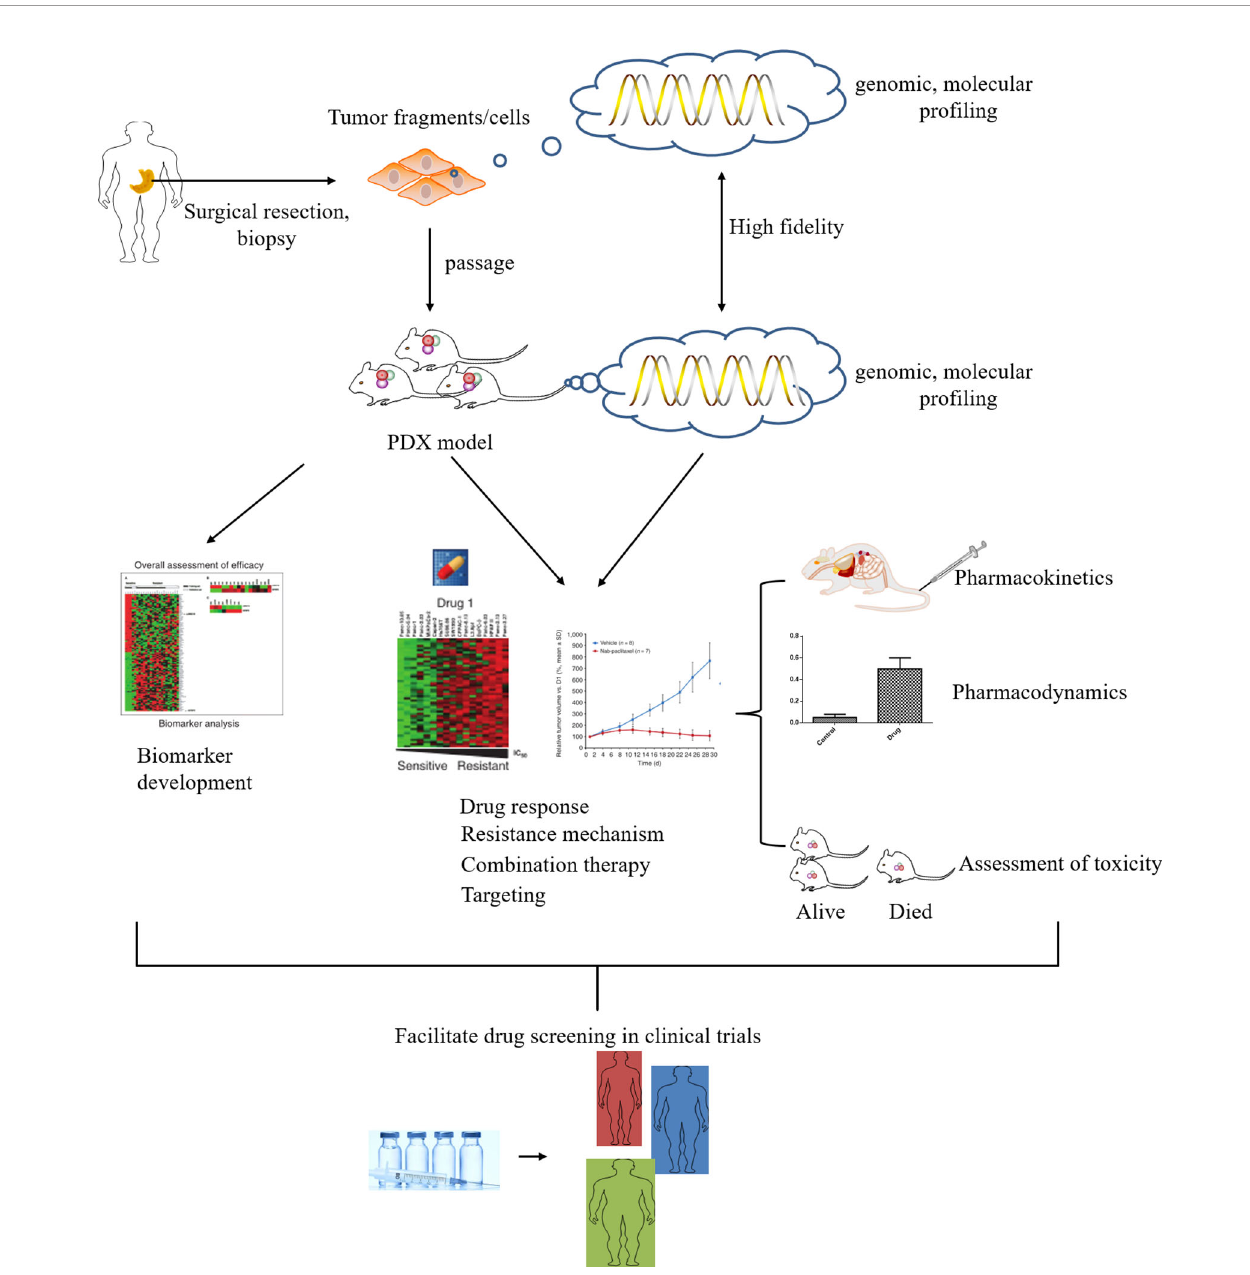
FIGURE 1 | The utility of patient-derived xenograft (PDX) models in gastric cancer research. The gastric cancer tissue or cells of the surgically resected patient was directly implanted into immunode fi cient mice, and the fi delity of the model was analyzed. The GCPDX model can be used for biomarker development or novel drug evaluation, etc. Promising candidates may enter clinical trials for evaluation to determine the optimal treatment for patients, enabling personalized